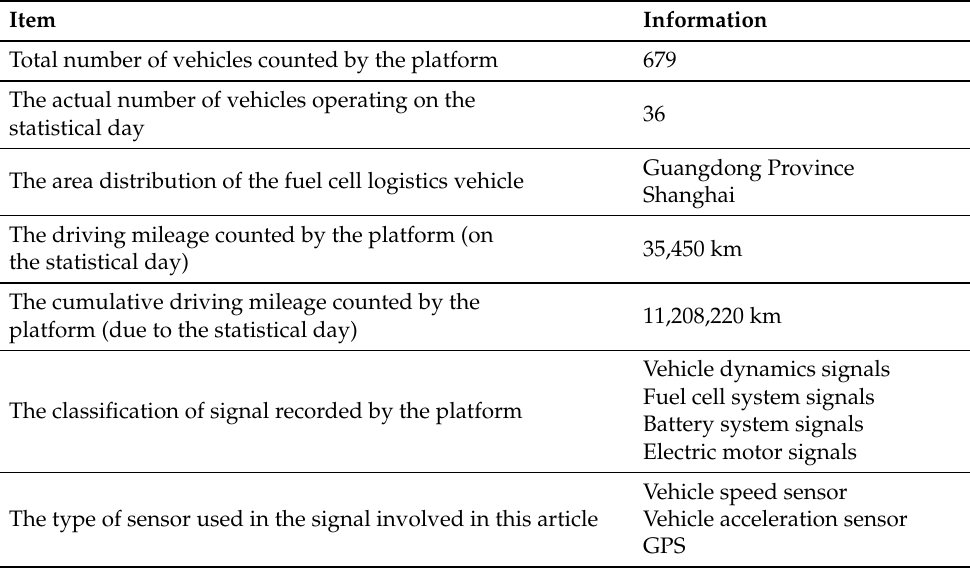
Table 1. The introduction of our data acquisition